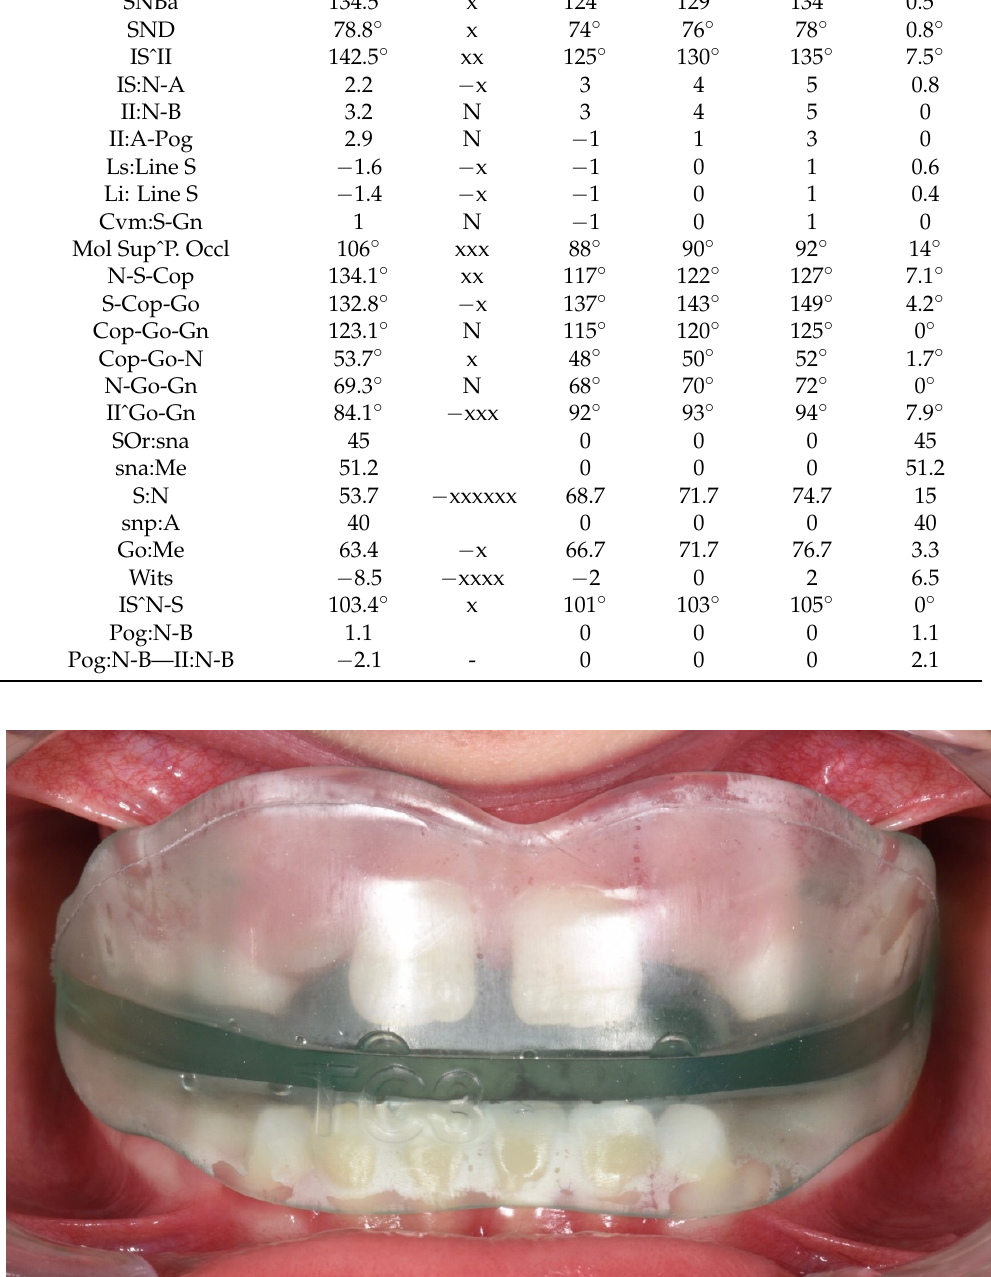
Figure 17. Intraoral photographs at the end of the treatment (8-year-old). ( A ) Frontal view; ( B , C ) lateral view. Figure 18. Final occlusal photos of dental arches (8-year-old). ( A ) Upper arch; ( B ) lower arch.